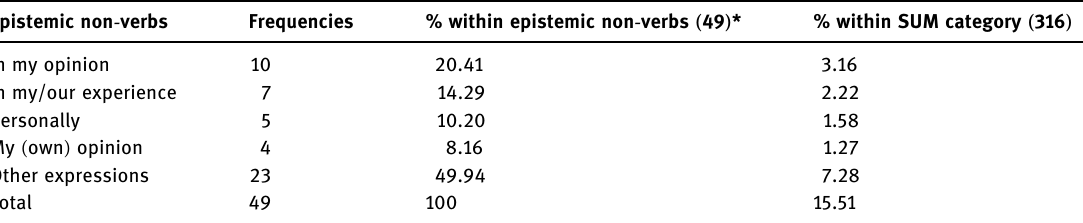
Table 10: Frequencies and percentages of the most frequent epistemic non - verbs conveying personal opinions in the whole corpus Epistemic non - verbs